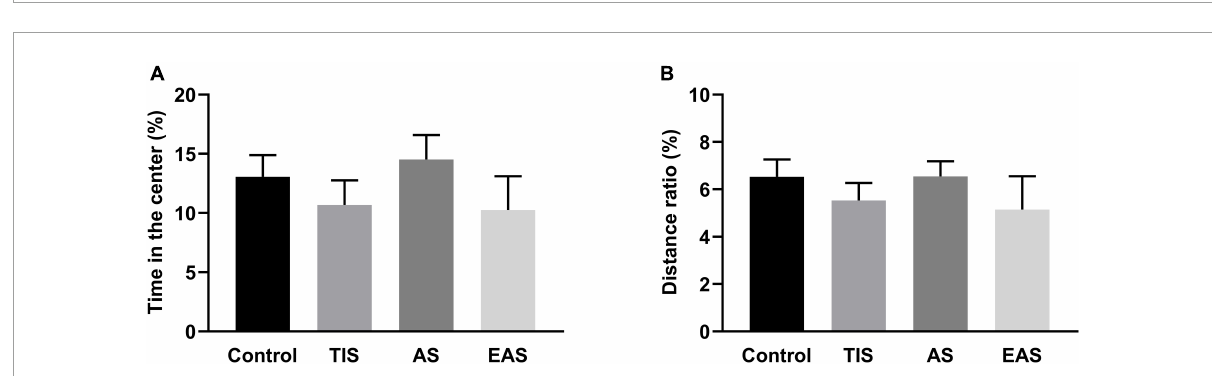
FIGURE4 Time in the center (A) and distance in the periphery/total distance ratio (B) of OF. There was no significant difference in time in the center and distance in the periphery/total distance ratio between groups. Data represent mean ± SEM ( n = 9–12 per group).